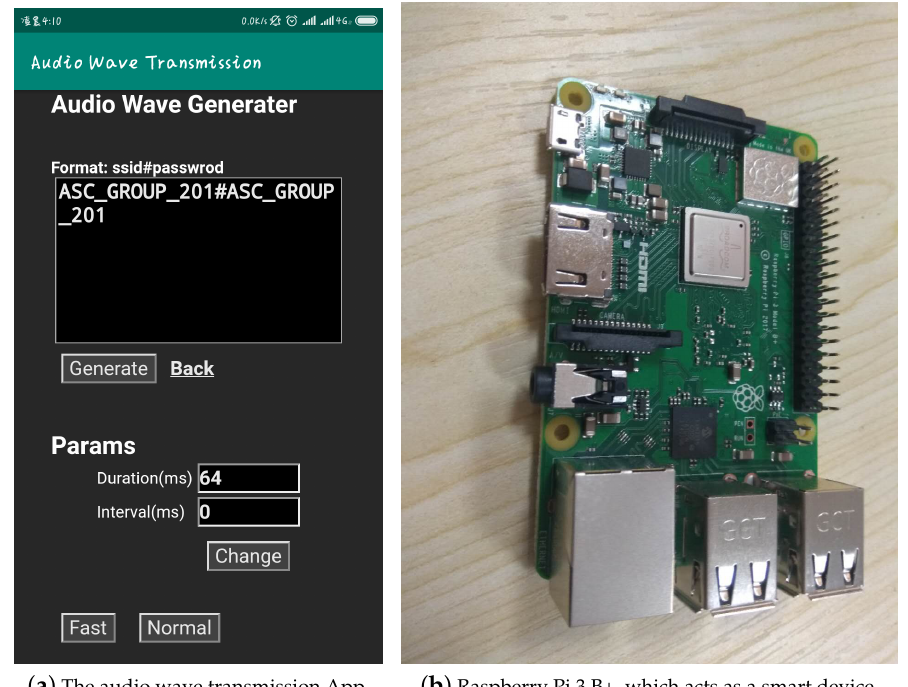
Figure 4. ( a ) The app can encode Wi-Fi credential into audio waves; and ( b ) the Raspberry Pi used to act as a smart device, which listen and decode audio